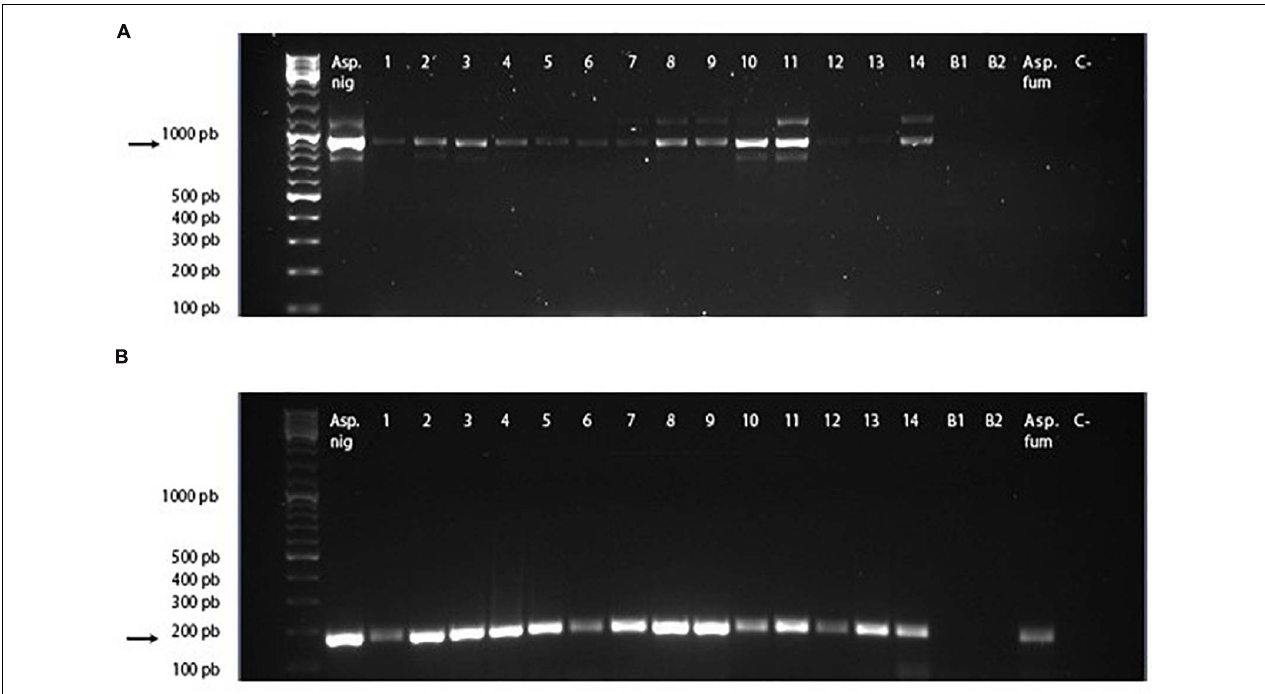
FIGURE 4 | cDNA PCR-amplified regions of Asp n gene. (A) Full cDNA gene amplicon using primers Aspn3_FW and Aspn3_RV . (B) Conserved cDNA gene region amplified using primers CRPEROX_FW and CRPEROX_FW . Asp. Nig, Aspergillus niger (positive control). Lines 1–14: samples of mangoes inoculated with spores of A. niger . B1 and B2: samples of mangoes inoculated with phosphate-buffered saline. Asp. fum, Aspergillus fumigatus . C- :PCR negative